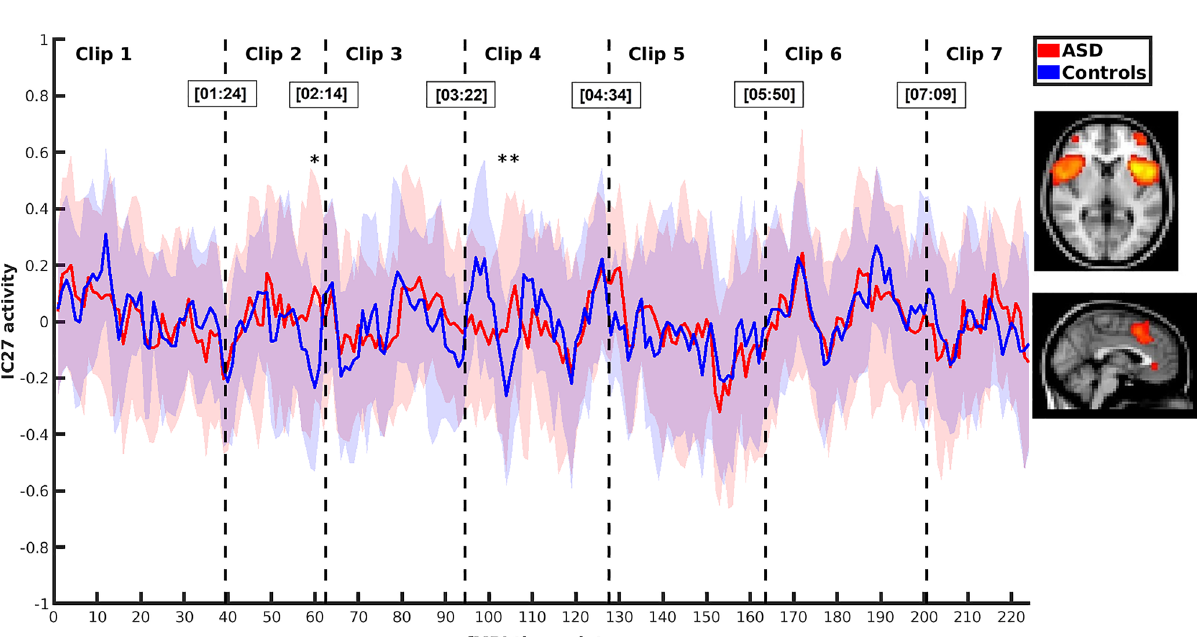
Figure 4. Average activity (± SD ) of IC27 in the ASD and NT groups during video clips 1–7 (* = significant difference after combining probability over IC4, IC15 and